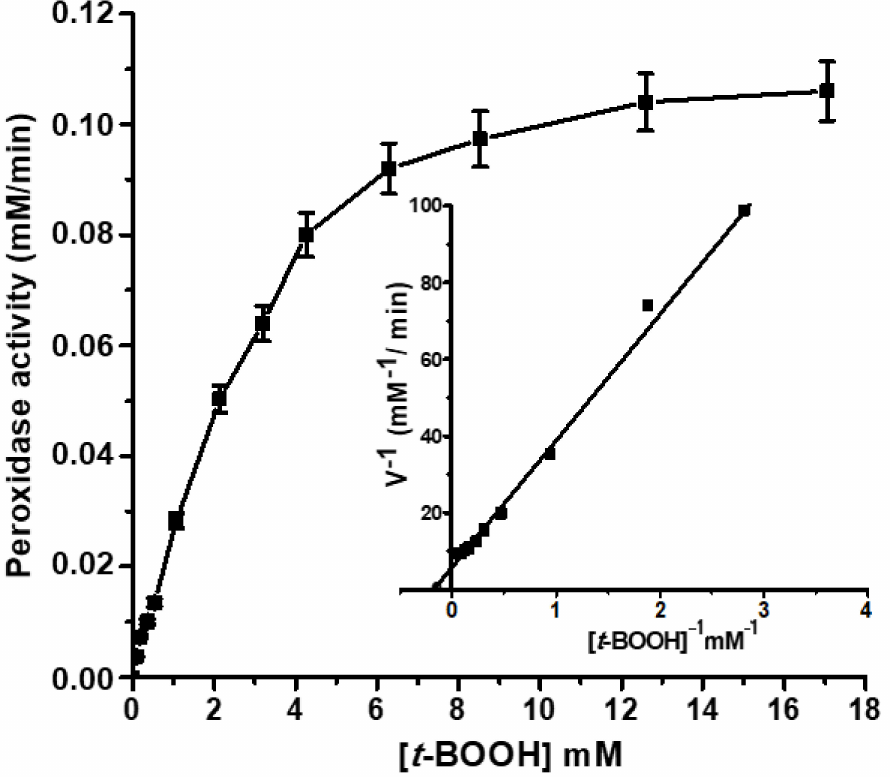
Figure 5. The dependence of the leghemoglobin (Lb) peroxidase reaction rate on the concentration of the substrate ( t -BOOH). The insert shows the dependence in the Linuiver–Burke coordinates. Peroxidase activity was measured in the presence of 8 µ M Lb and 0.8 mM o -dianisidine. Lb can function in peroxidase oxidation/reduction cycle only in the presence of (GSH) is an effective low-molecular-weight reducing agent for Lb IV =O [50]. In